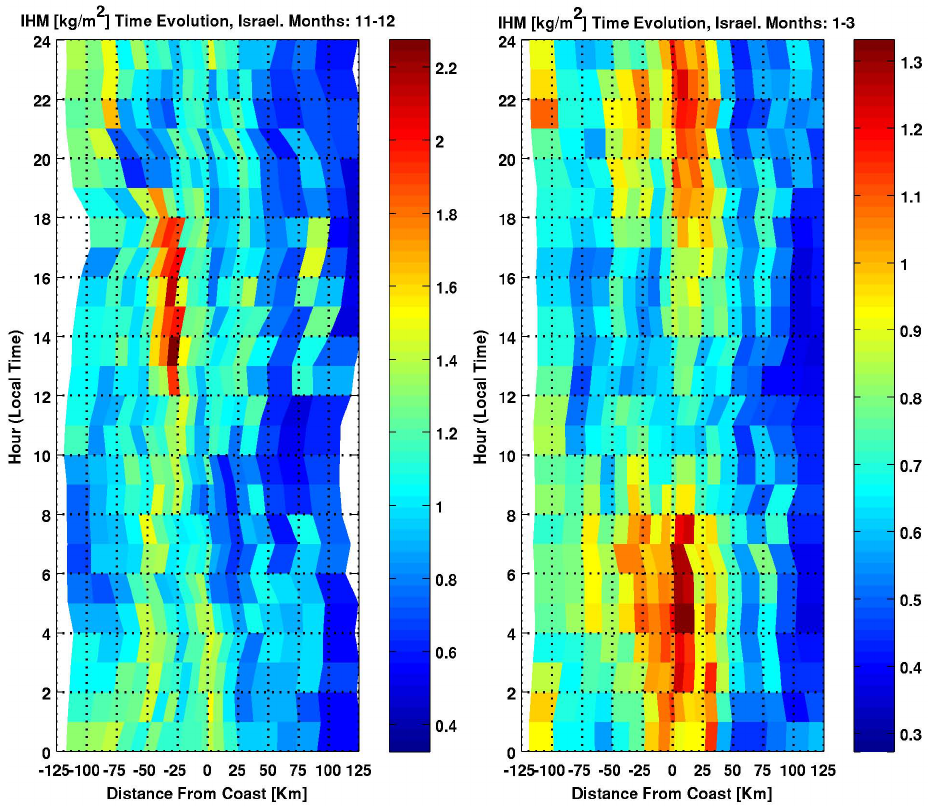
Fig. 8. Integrated Hydrometeor Mass (liquid+ice) time evolution with respect to coastline for November–December (left figure) and January– March (right figure), in the “Israel” sub-region. Color bar scale represents IHM (kgm − 2 ); notice that color bars are scaled differently for each sub-season in order to enhance the diurnal variance. Data was sorted as a function of distance from nearest coastline and local time (into 20 bins). Y axis numbers are the center local time of the ± 3h averaging time span, running from 00:00 (midnight) to 24:00. To interpret